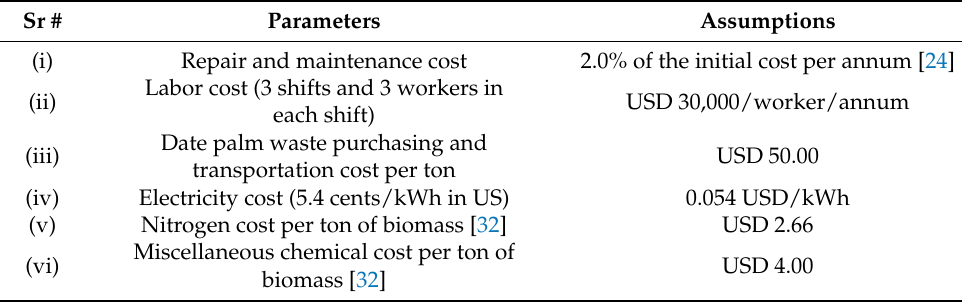
Table 6. Assumptions to work out variable